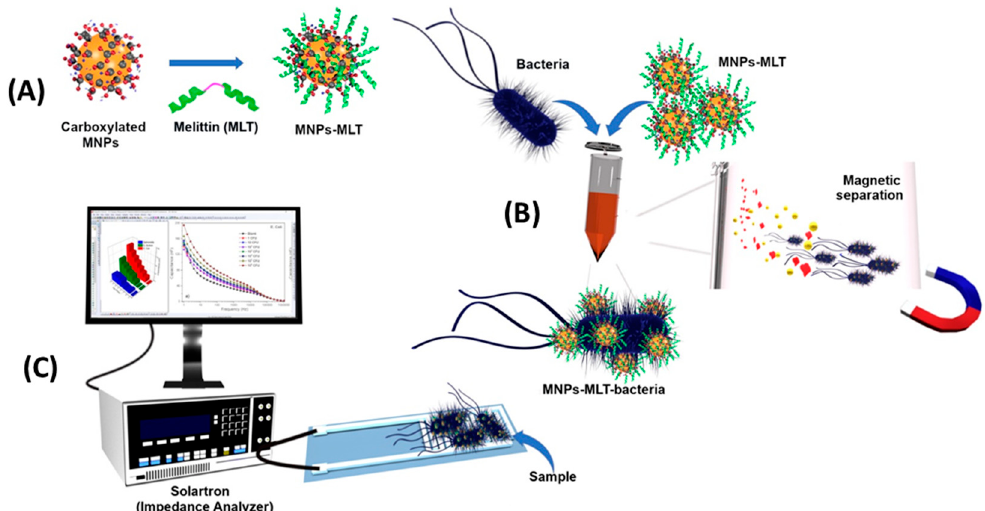
Figure 6. Schematic representation of the EIS biosensor based on magnetic nanoparticles functionalized with antimicrobial peptides. ( A ) Functionalization of MNPs with Melittin. ( B ) Capture of bacteria by MNPs-MLT, and magnetic separation of bacteria from the sample matrix. ( C ) EIS detection [121]. Copyright 2019, Elsevier.